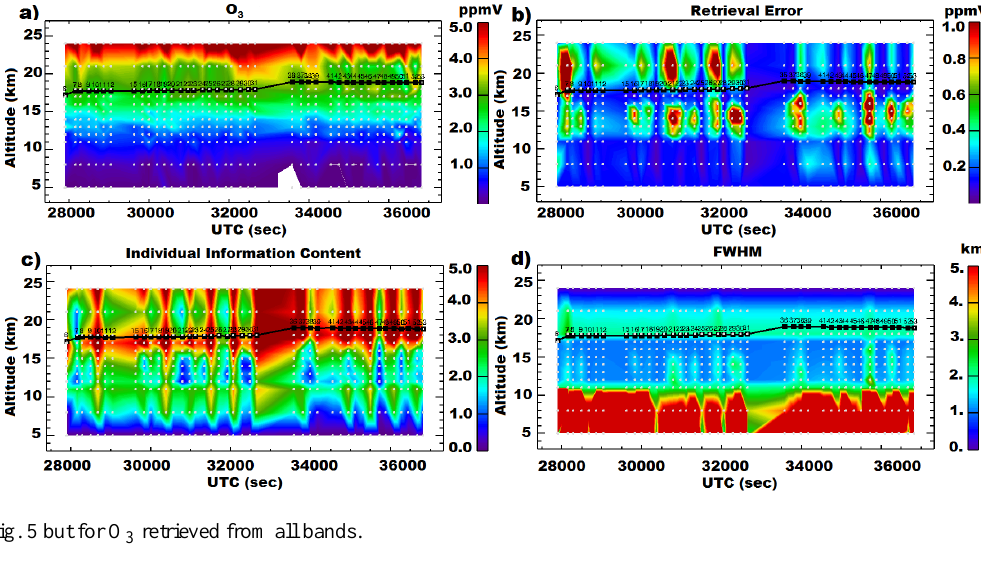
Fig. 8. As in Fig. 5 but for O 3 retrieved from all bands.